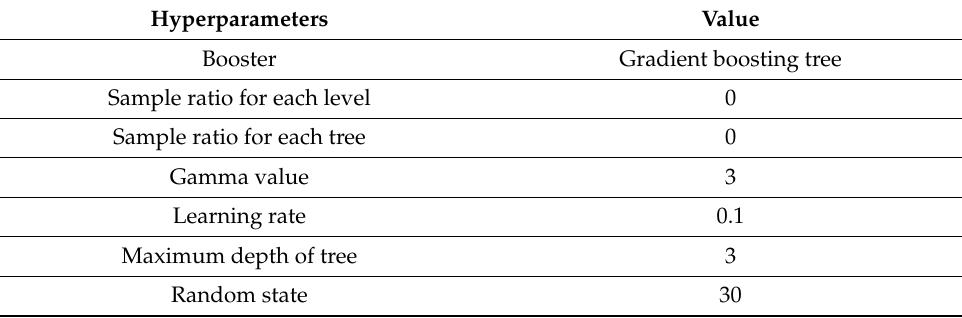
Figure 8. Boosting in Machine Learning [41]. Table 7. Fixed Hyperparameters in XGBoost